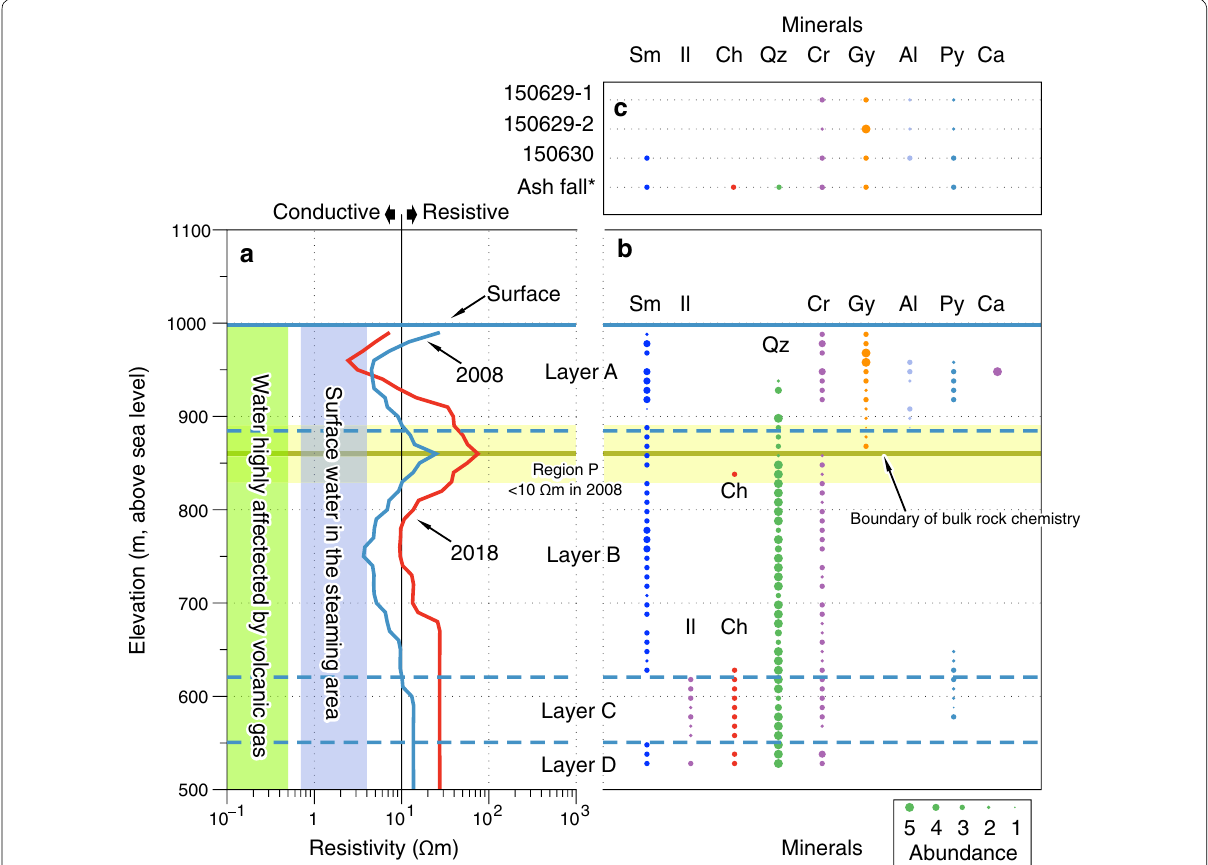
Fig. 8 Geological classification of SPW52 based on a resistivity structure of closest point to SPW52 and b altered mineral assemblage. The resistivity structure of a is extracted from a 2D resistivity model along survey line Fa. The altered mineral assemblages of the 2015 eruption products are also displayed ( c ). The abbreviations of the mineral names and abundance classification are defined in Table 1. The definition of each layer appears in the text. Layer A appears to have formed different minerals due to the alteration of the original local rocks (Fig.